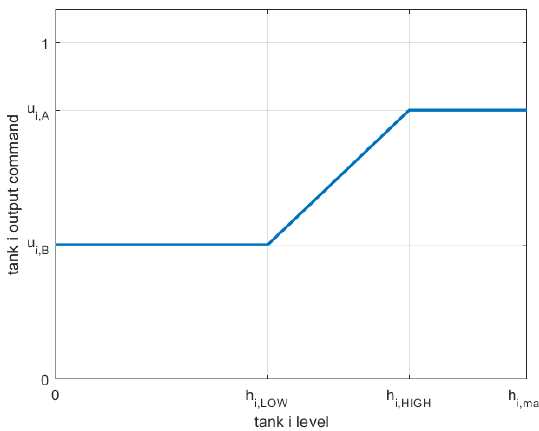
Figure 17. Strategy #4 control depending on the liquid level in the tank.